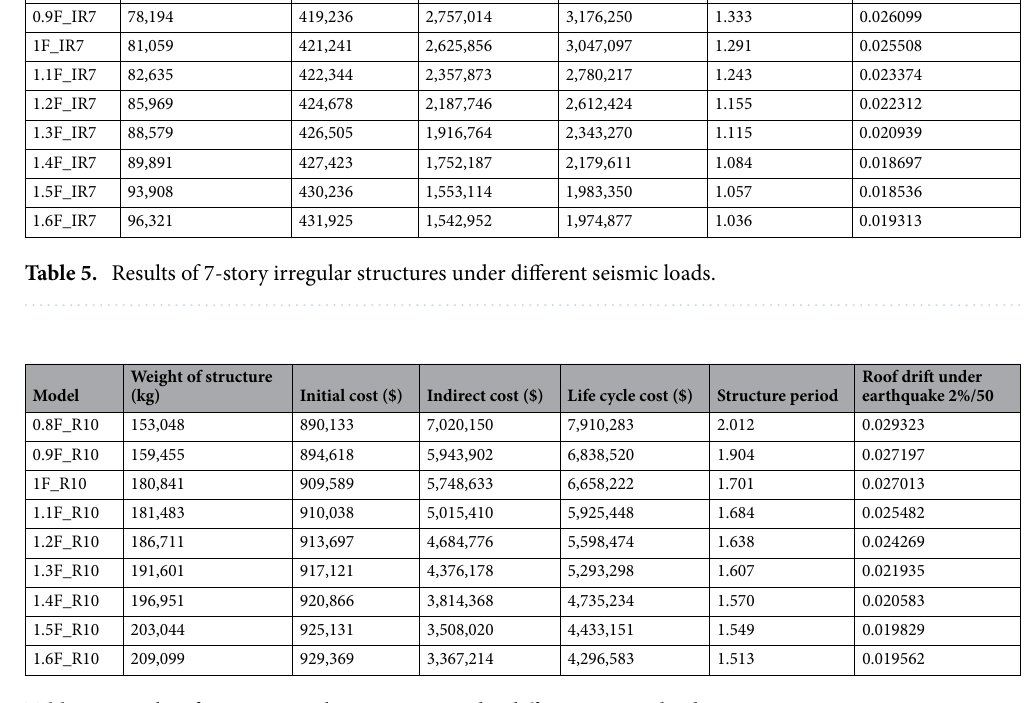
Table 6. Results of 10-story regular structures under different seismic